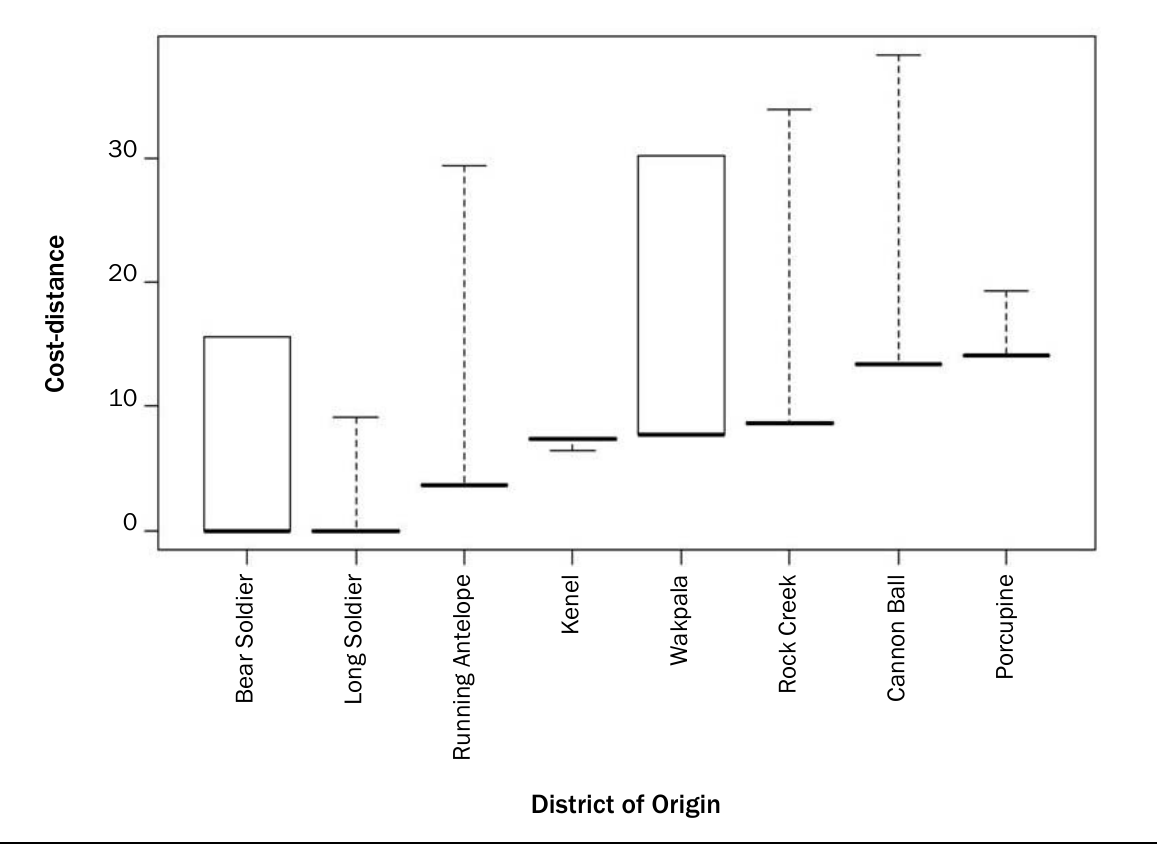
Most trips were made to the minimum cost-distance. Cost-distance is a measure that incorporates the distance and difficulty of travel. In this figure, bars represent medians, boxes represent interquartile ranges, and whiskers represent minimum and maximum cost-distance values for